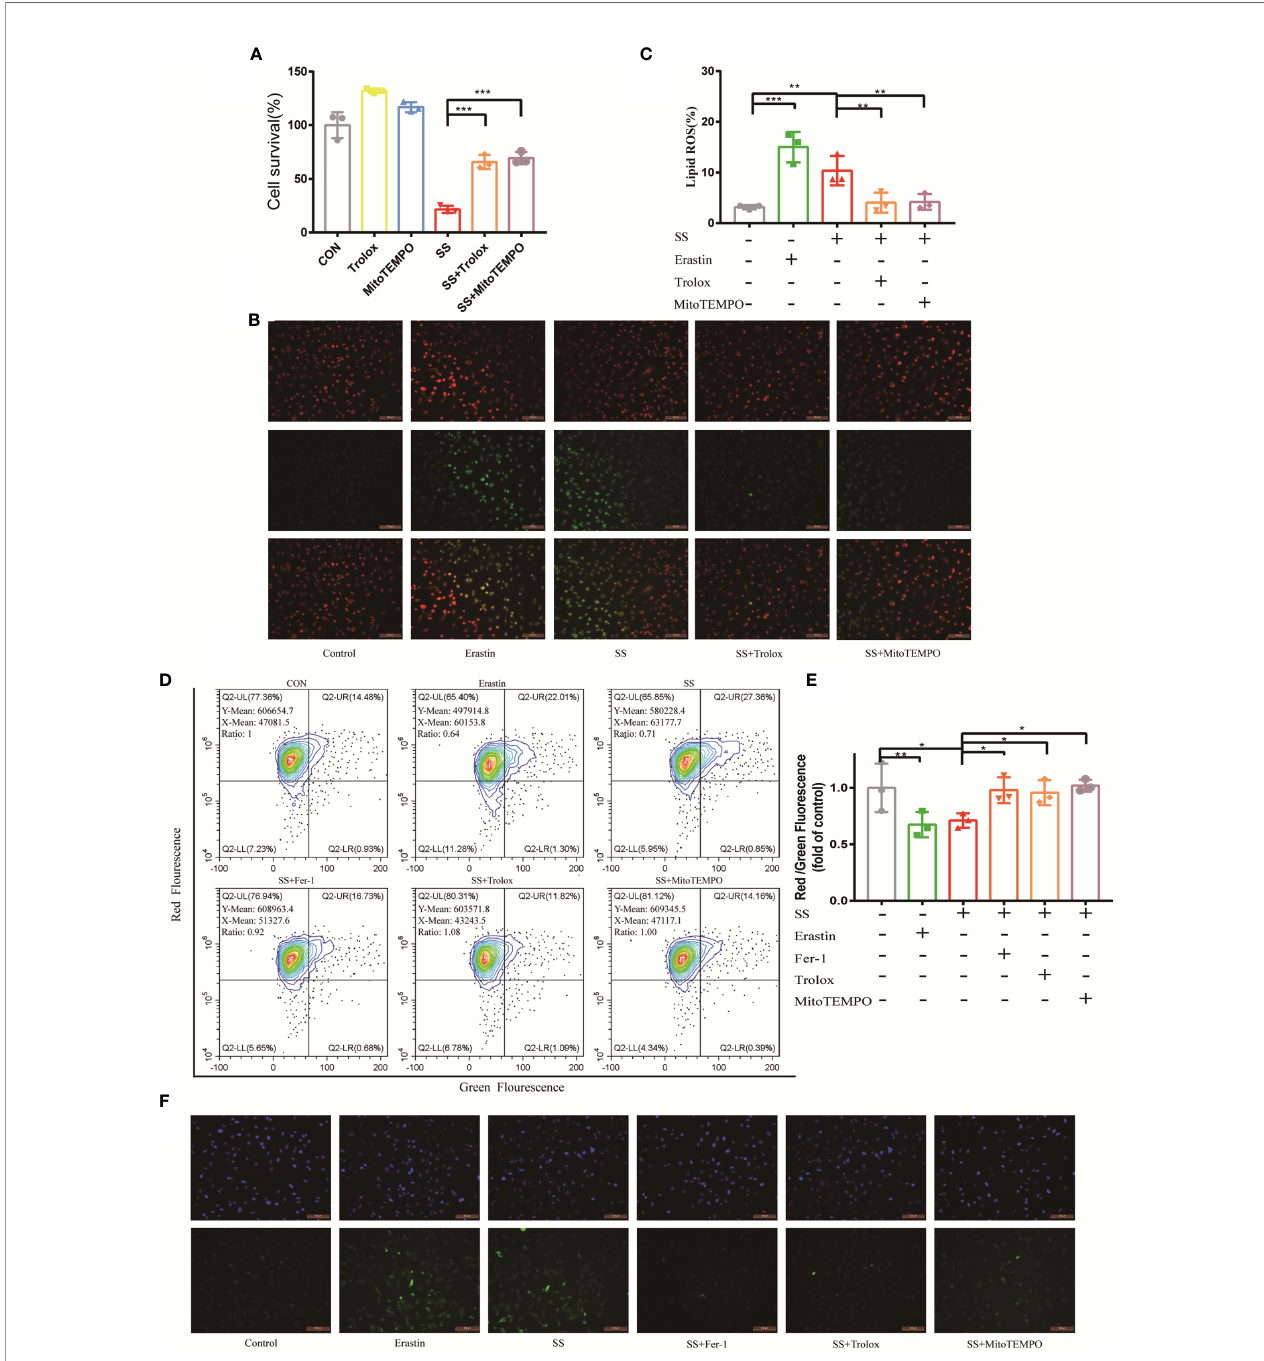
FIGURE 5 | The dysfunction of mitochondria contributed to solasonine-induced ferroptosis in LUAD cells. (A) CCK8 assay was used to determine the cell viability of Calu-1,which were treated with 20 m M SS, and pretreated with or without Trolox (100 m M) or Mito TEMPO (10 m M). (B) Fluorescence microscopy was used to detect the lipid ROS production in Calu-1cells, which were treated with 20 m M SS for 6 h and pretreated with or without Trolox (100 m M) or Mito TEMPO (10 m M). Scale bars: 100 m m. (C) Flow cytometry was used to detect the double signals of C11-BODIPY581/591, which were then digitized and analyzed using histogram statistics (*P < 0.05, **P < 0.01, ***P < 0.001). (D) JC-1 staining was used to detect the mitochondrial transmembrane potential ( Dy mt) in Calu-1 cells, which were treated with 20 m M SS or erastin (4 m M) for 6 h and pretreated with or without Fer-1 (1 m M), Trolox (100 m M), or Mito TEMPO (10 m M). (E) Quantitative analysis of red/green fl uorescence ratio of cells. (F) Fluorescence microscopy was used to detect the lipid ROS of mitochondria in Calu-1cells, which were treated with 20 m M SS or erastin for 6 h and pretreated with or without Fer-1 (1 m M), Trolox (100 m M), or Mito TEMPO (10 m M). Scale bars: 100 m m. Nuclei were stained with Hoechst 3342. Scale bars: 100 m